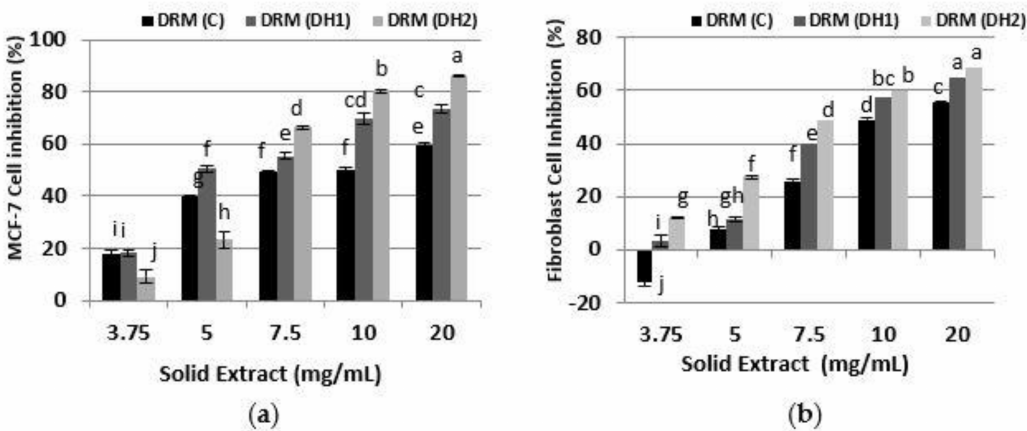
Figure 4. Cell inhibition of protein hydrolysates extracted from DRM. ( a ) on MCF-7 cancer cell line, ( b ) on healthy human fibroblast cell. Percentages of inhibition are calculated in reference to the signal of cells grown of extract-free cell culture media. Mean ± SD ( n = 3). The same letter means there is no significant difference ( p < 0.05), 95% confidence